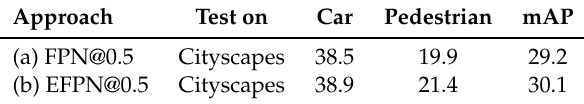
Table 4. Object detection results evaluated on Cityscapes.